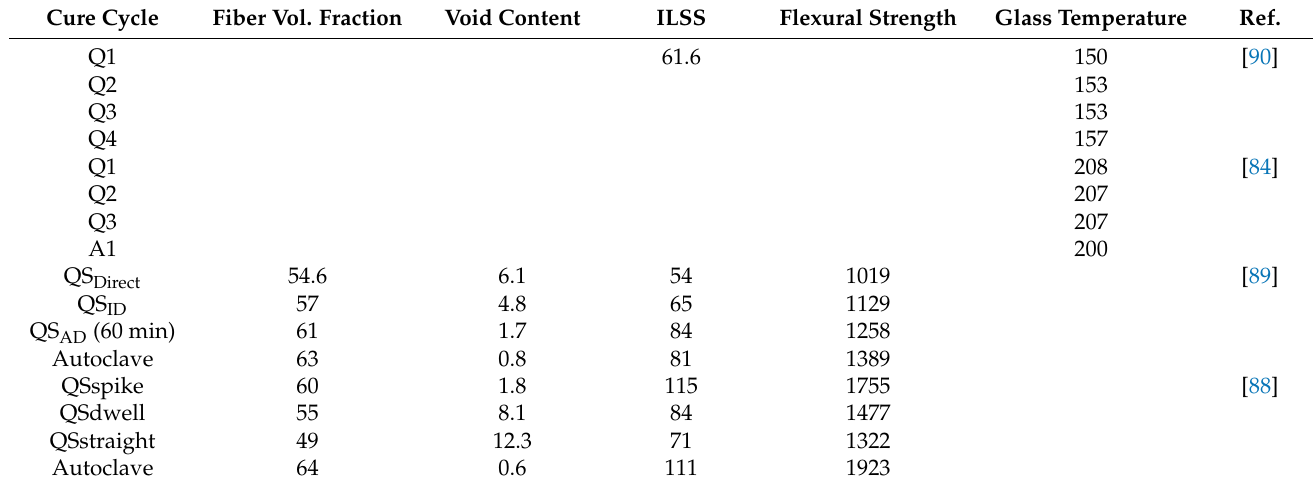
Table 4. Mechanical Properties of Different Quickstep Cure Cycles (in Table